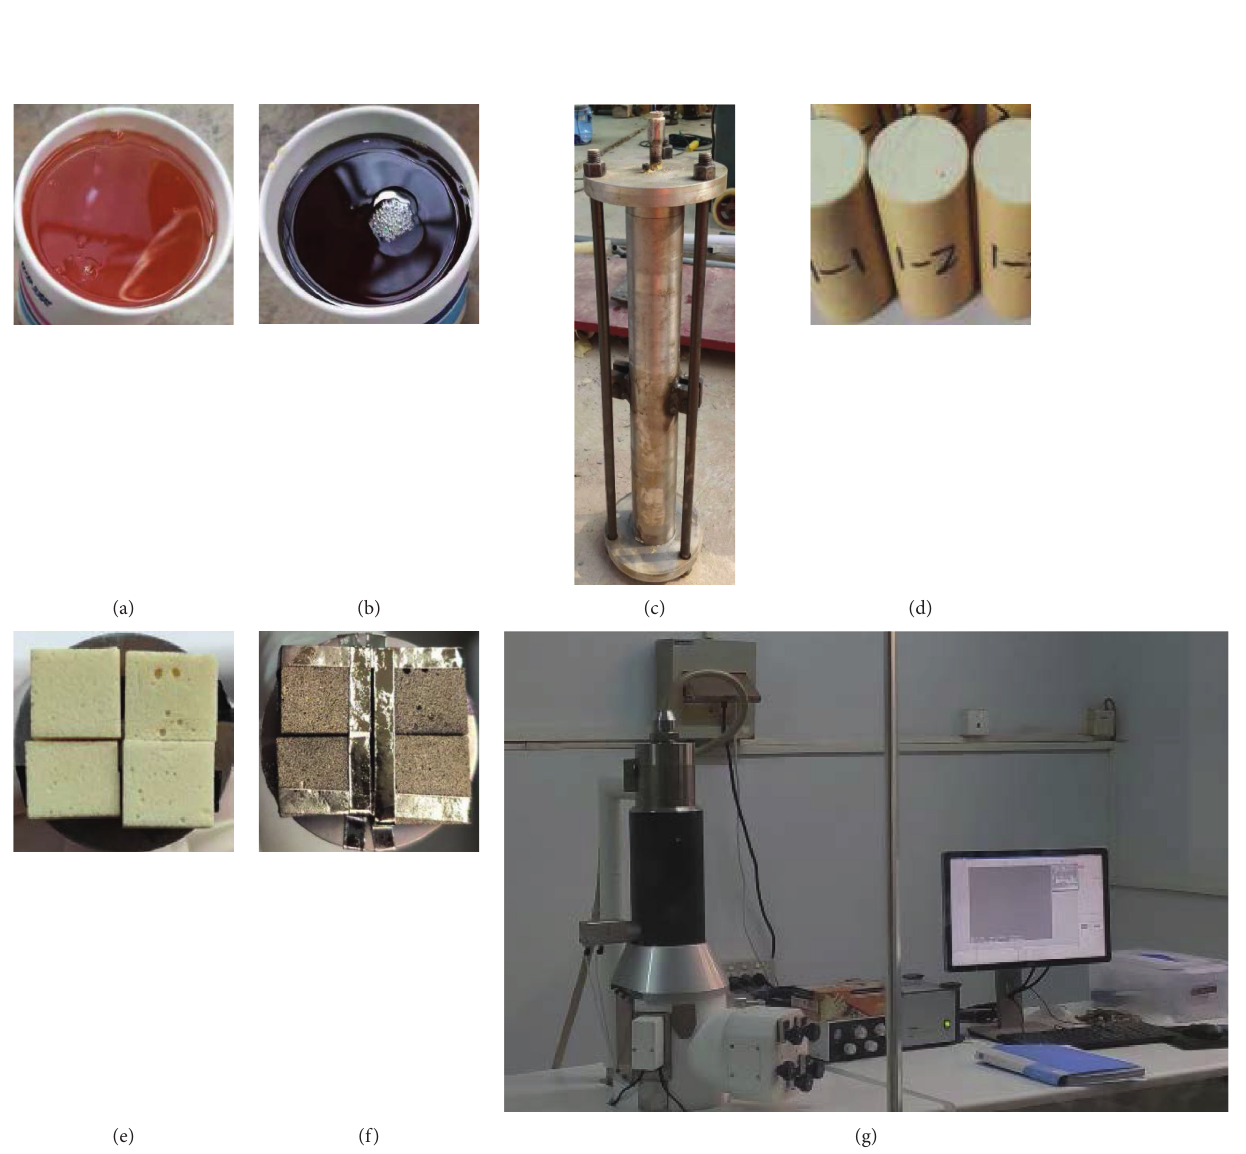
Figure 1: Raw material, sample preparation, and the primary instrument. (a) Material A; (b) material B; (c) grouting forming polymer; (d) specimen of polymer; (e) observation sample; (f) target section spraying gold; (g) SEM.